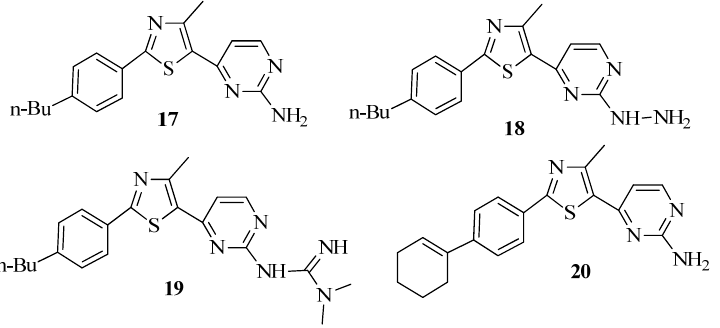
Figure 8. Structures of 2-(1-(2-(4-butylphenyl)-4-methylthiazol-5-yl)ethylidene)aminoguanidine analogues.